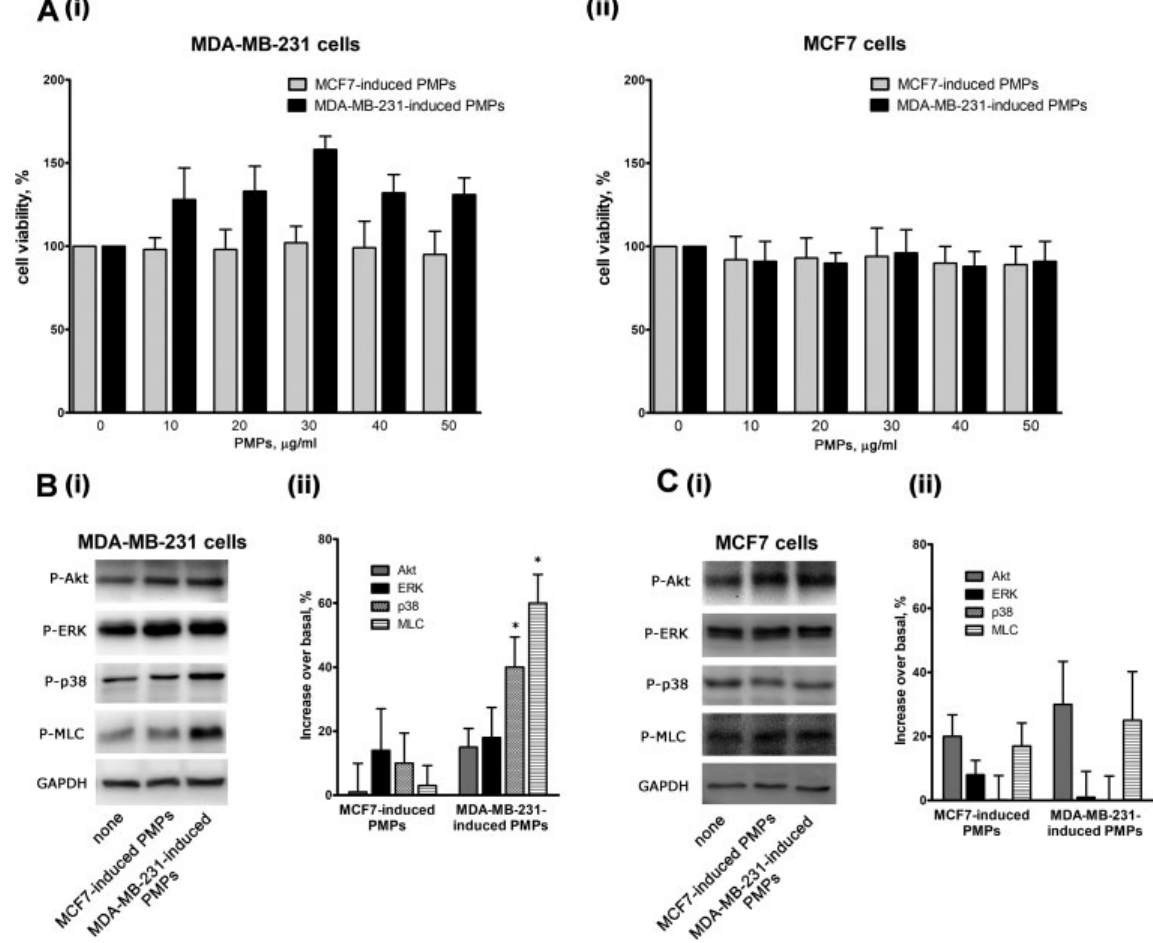
Fig. 3 Platelet-derivedmicroparticles(PMPs)-inducedactivationofMDA-MB-231cells.( A )ViabilityofMDA-MB-231(i) orMCF7(ii)cellsincubatedwiththe indicatedamountsofPMPsfor24hourswasassessedbyacolorimetricMTTassay.Resultsarereportedasthemean (cid:4) SEMof threedifferentexperiments. ( B and C ) Phosphorylation of selected signaling proteins in MDA-MB-231(panel B) or MCF7 (panel C) cells incubated with MCF7- or MDA-MB-231-induced PMPs for 18 hours, as indicated on the bottom. Representative immunoblot with speci fi c anti-phosphoprotein antibodies directed against the protein indicatedontherightisreportedin(i),whereGAPDHstainingisforequalloadingcontrol.Quanti fi cationoftheresultsbydensitometricscanningisreported in (ii), as % of phosphorylation increase over the level of untreated cells. Results are the mean (cid:4) SEM of three different experiments. (cid:1) p < 0.05. TH Open Vol. 1 No.